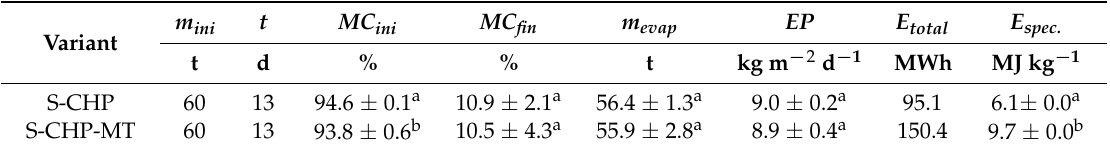
Figure 3. Cumulative energy input E total from solar energy E solar , waste-heat from a combined heat and power unit E CHP and exhaust gas from a micro turbine E MT for drying of biogas digestate; (left) variant S-CHP with solar energy E solar and waste-heat of a combined heat and power unit E CHP ; (right) variant S-CHP-MT with solar energy E solar , waste-heat of a combined heat and power unit E CHP and exhaust gas from a micro turbine E MT . Table 2. Initial and final moisture content MC ini and MC fin , mass of evaporated water for the drying of digestate in a solar greenhouse dryer with waste-heat from CHP (variant S-CHP) and additional heat from a micro turbine (variant S-CHP-MT). Mean values ± standard